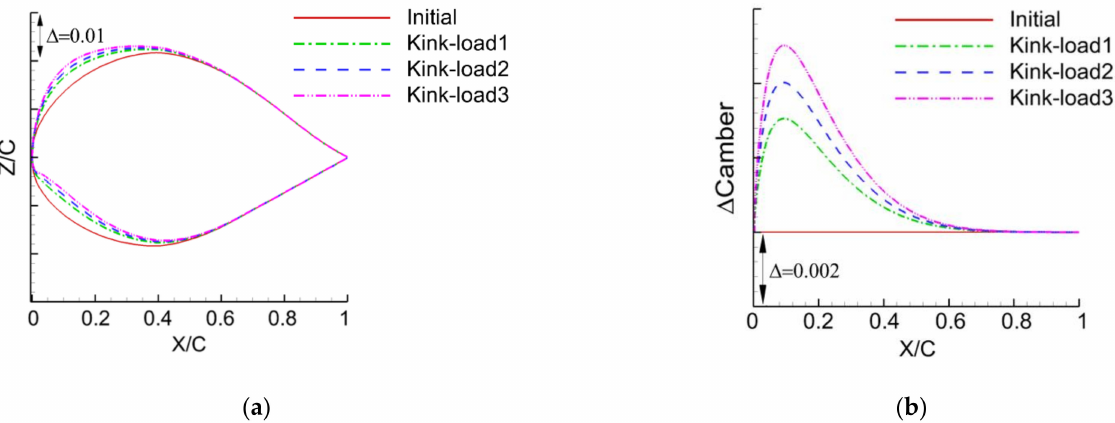
Figure 16. The fore-loading modification of kink airfoil. ( a ) Airfoils comparison; ( b ) Different camber